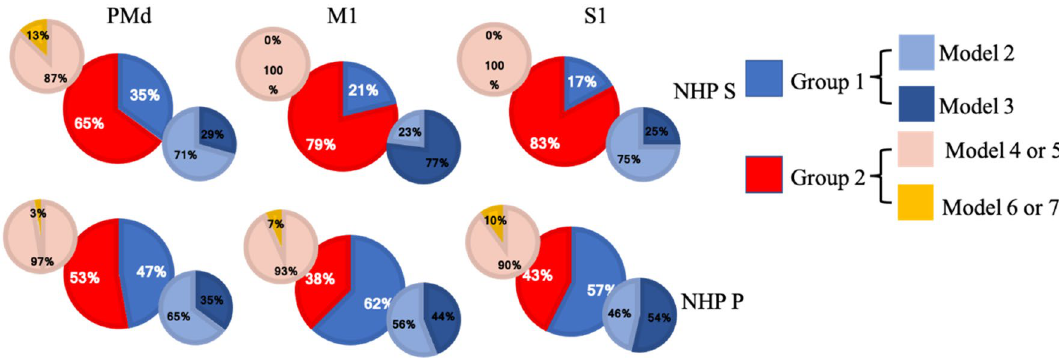
Figure 11. Percentage of units firing rate best fit for a given divisive normalization model. Group 1 models include both successful and unsuccessful trials, where model 2 utilized task R and P levels and model 3 utilized the population activity. Group 2 models include successful trials only (models 4, 6), or unsuccessful trials only (models 5, 7), with models 4 and 6 utilizing task R or P levels respectively, and models 5 and 7 using population activity in the divisive term from R or P trials respectively.